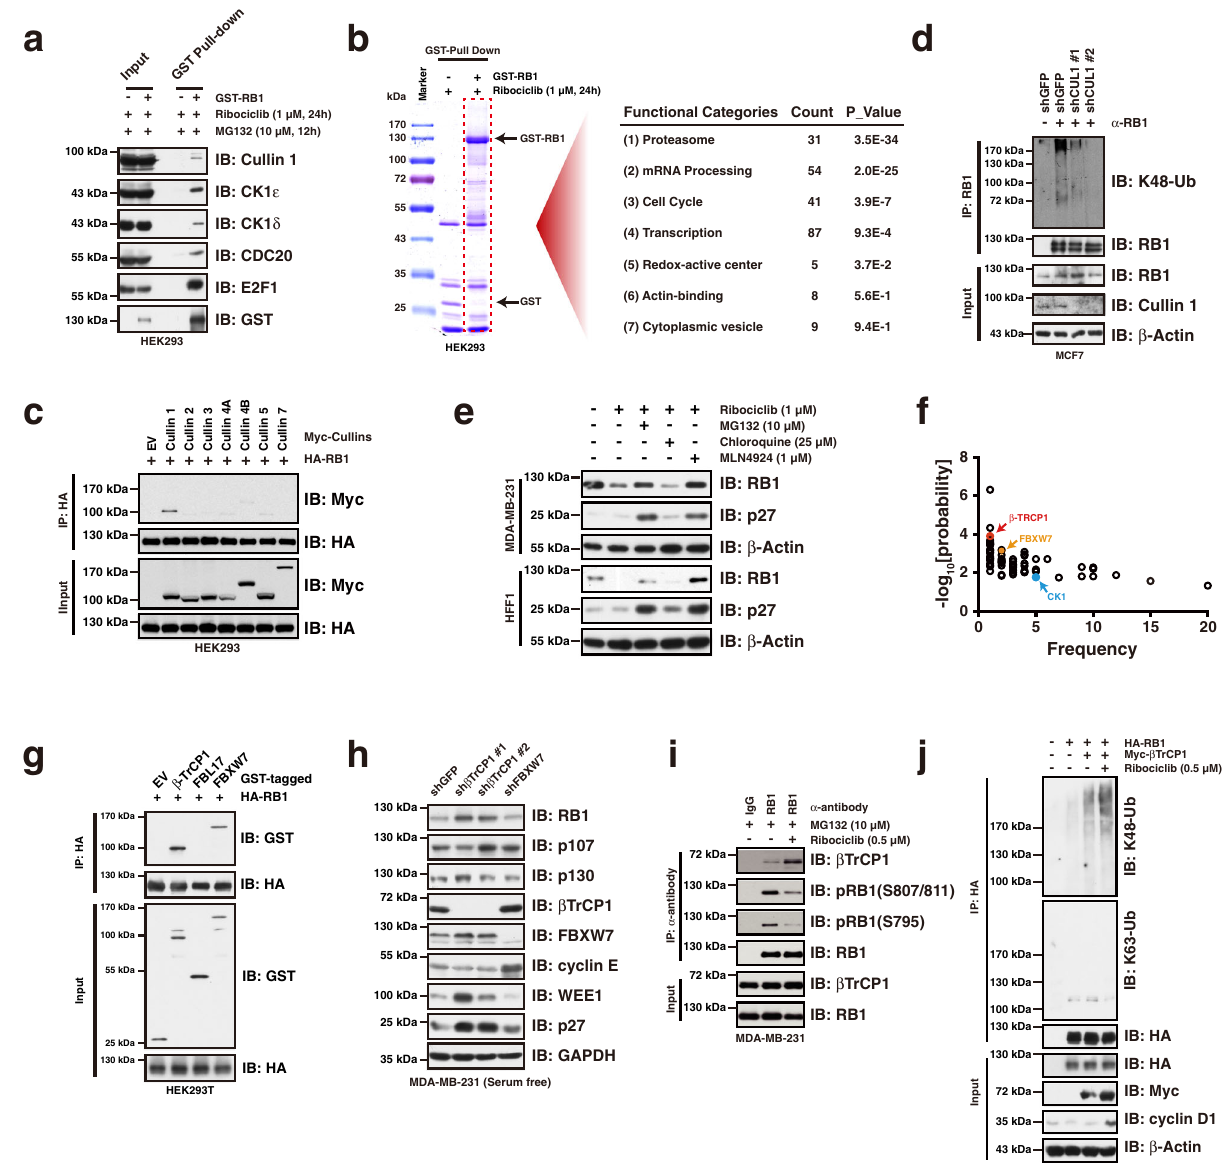
Fig. 2 β TrCP1 mediates RB1 for proteasomal degradation upon CDK4/6i treatment. a Immunoprecipitation assay validating the interaction between RB1 and its interacting proteins identi fi ed by LC-MS/MS. b Gene functional classi fi cation of RB1-MS results showing that proteasome related proteins were signi fi cantly enriched in the GST-RB1 precipitates upon CDK4/6i treatment. Functional categories analysis was performed by the DAVID tools (https://david.ncifcrf.gov/home.jsp). The P values associated with each annotation terms inside each cluster were determined by Fisher Exact test. c Immunoprecipitation assay showing RB1 speci fi cally interact with Cullin 1 in cells. d Knocking-down of Cullin 1 diminished K48-linked polyubiquitination of RB1 in MCF7 cells. e Exposure of HFF1 and MDA-MB-231 cells with MG132 and MLN4924 blocked ribociclib treatment induced RB1 reduction. f Eukaryotic Linear Motif (ELM) prediction of RB1 protein showing that β TrCP1, FBXW7, and CK1 are potential RB1 interacting proteins. The prediction was performed by the tool of The Eukaryotic Linear Motif resource for Functional Sites in Proteins (http://elm.eu.org/index.html). g Immunoprecipitation assay showing that β TrCP1 and FBXW7 physically interacted with RB1 in cells. h Knocking-down of β TrCP1 , but not FBXW7 , led to RB1 accumulation in the context of serum starvation in MDA-MB-231 cells. i Immunoprecipitation assay showing that ribociclib treatment facilitated the interaction between RB1 and β TrCP1. j Ectopic expression of β TrCP1 elevated K48-linked polyubiquitination of RB1 in cells. Data are presented as mean values ± SEM. The relevant raw data and uncropped blots are provided in Source